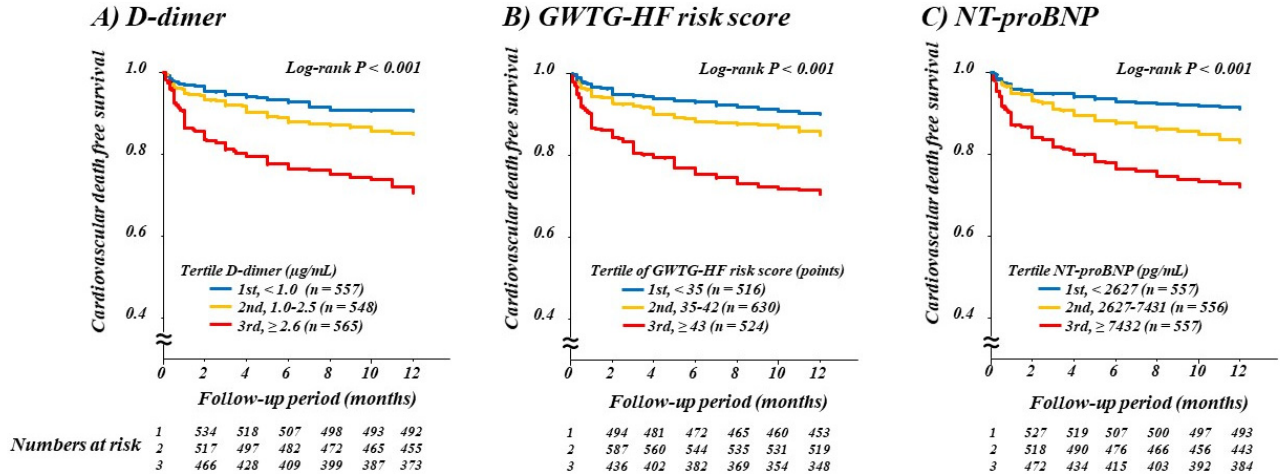
Figure 2. Kaplan-Meier curves for cardiovascular mortality according to tertiles of D-dimer, GWTG-HF risk score, and NT-proBNP. Numbers at risk of respective groups are shown below the plots. GWTG-HF, Get With The Guidelines—Heart Failure; NT-proBNP, N-terminal pro-B-type natriuretic peptide. ( A ) D-dimer; ( B ) GWTG-HF risk score; ( C ) NT-proBNP. Table 2. Multivariate predictors of all-cause mortality in all study